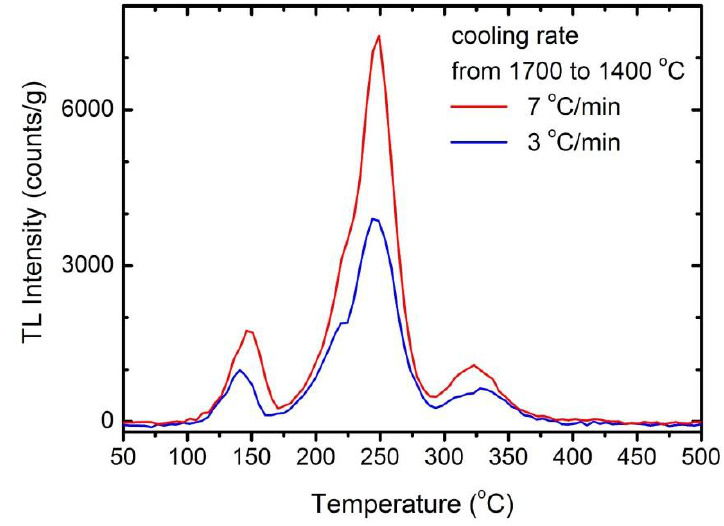
Figure 3. TL glow curves of Lu O :0.05%Pr,0.1%Hf ceramics annealed for 5 h at 1700  C 2 3 in forming gas. One sample was cooled at the rate of 7  C/min in the range of 1700–1400  C and 3 °C/min below 1400 °C, while the other one at the constant rate of 3